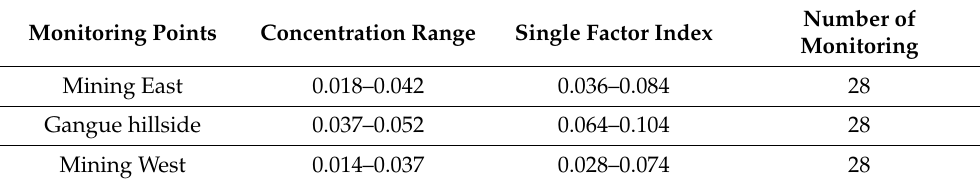
Table 3. Evaluation results of the hourly average concentration range of SO 2 .